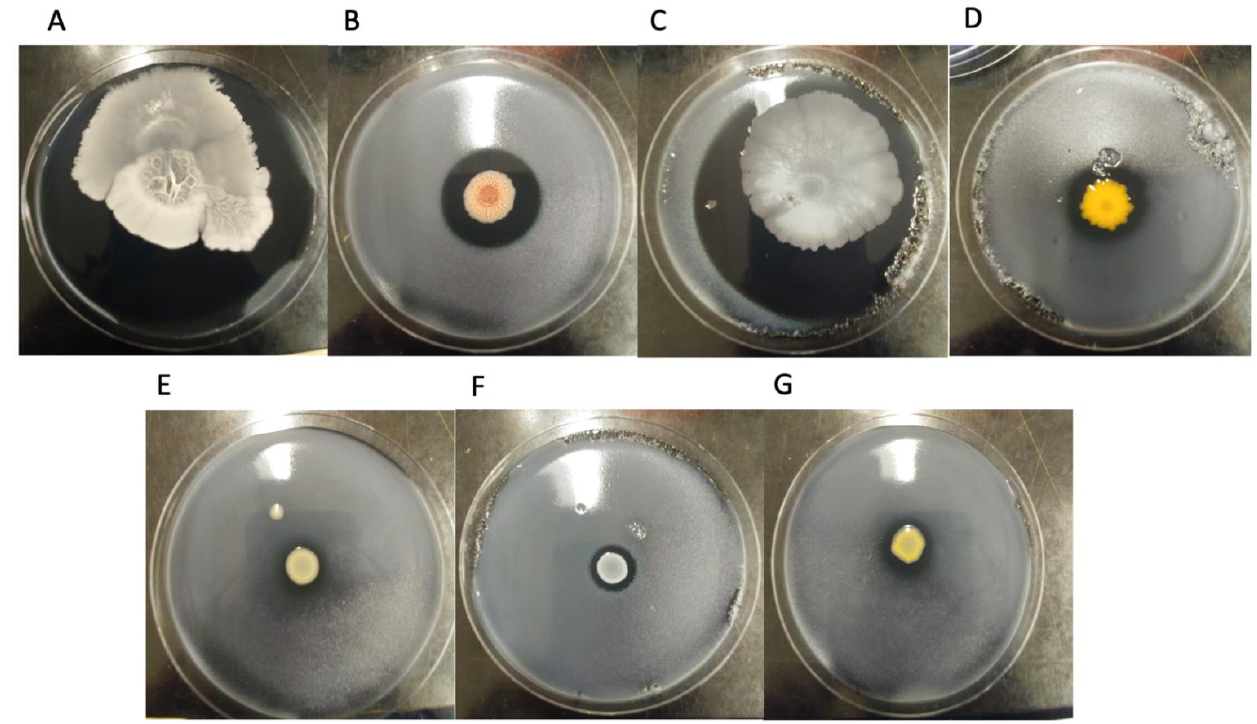
Figure 1. Isolates showing inhibition zones on a lawn of L. pneumophila (LpS256P) on CYE agar incubated at 30 ◦ C for 4 days. Isolates are: ( A ) Bacillus amyloliquefaciens (SPF474), ( B ) Bacillus par- alicheniformis (SPF497), ( C ) Bacillus subtilis (SPF437), ( D ) Chryseobacterium sp. (SPF475), ( E ) Cupriviadus sp. (SPF499), ( F ) Staphylococcus epidermidis (SPF476), and ( G ) Stenotrophomonas sp. (SPF498), identified by 16S rRNA and whole genome sequencing.